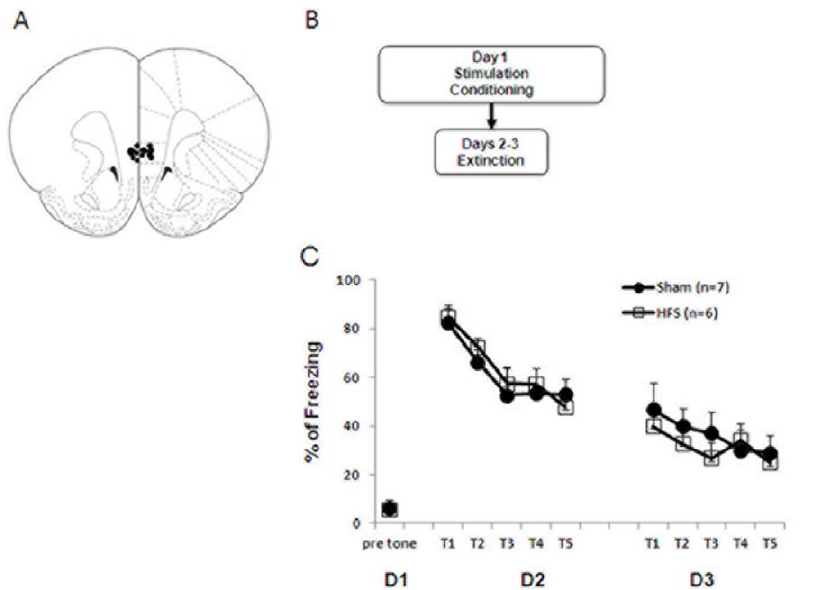
Figure 3. IL-HFS applied immediately before conditioning does not alter fear during extinction. ( A ) Schematic diagram showing electrode placement in IL [56] for the fear conditioning experiments. ( B ) Timeline of behavioral testing and stimulation. ( C ) Percent freezing to CS during conditioning, fear retrieval, and extinction in rats receiving either sham or HFS prior to conditioning. Sham and HFS rats did not differ during any phase. Data are Means 6 SEM.